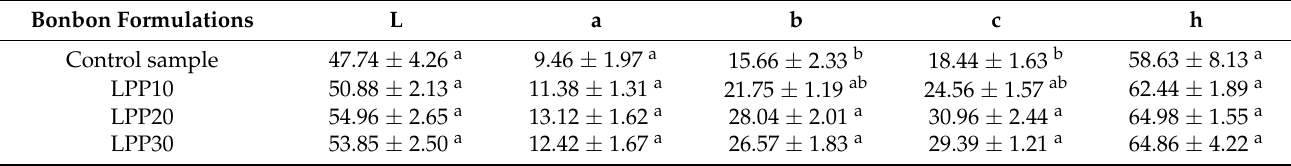
Table 4. CIELAB color spectra of bonbon